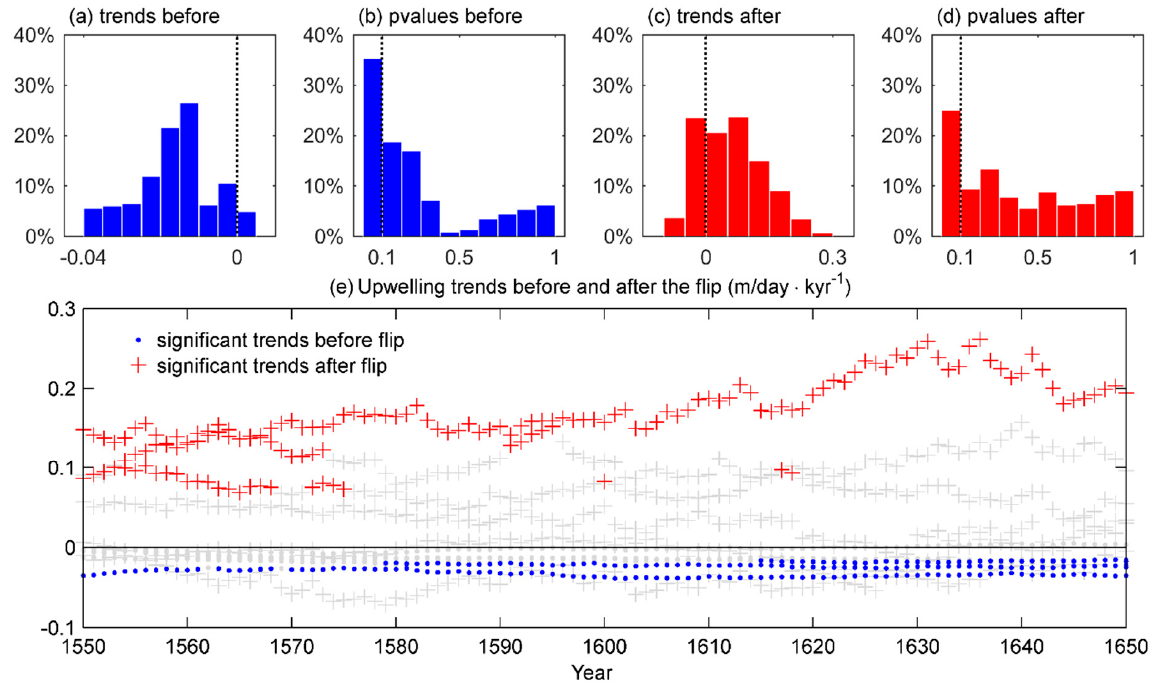
Figure 10. Histograms of ( a ) trends and ( b ) p -values for the period before the selected flip point. Histograms of ( c ) trends and ( d ) p -values for the period after the selected flip point. ( e ) Trends before (dot) and after (plus) each flip point from 1550 to 1650. The colored markers show significant trends with p -value < 0.1.